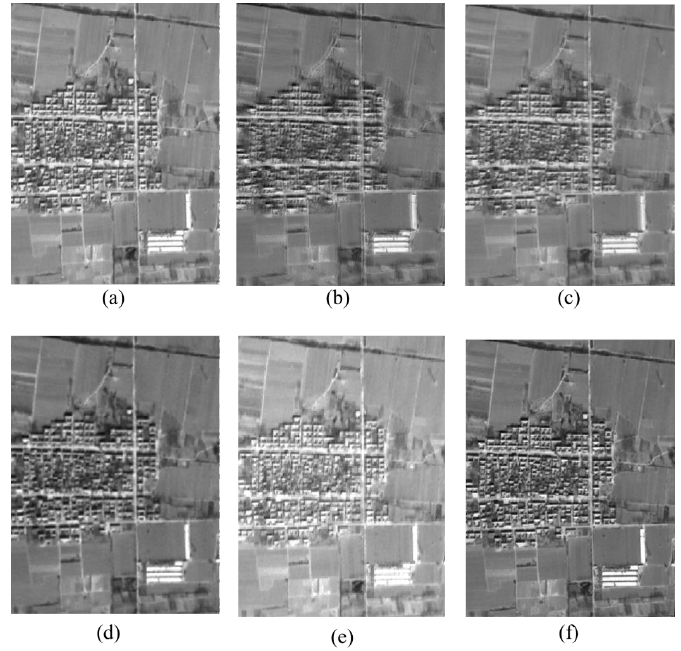
Figure 3. Comparison of the experimental ZY-3 image from nadir image, forward image, backward image, and super resolution image from forward image + nadir image, and super resolution image from backward image + nadir image, and SR image for all TLC images: ( a ) the nadir image; ( b ) the forward image; ( c )the backward image; ( d ) the super resolution image from the nadir image + forward image; ( e ) the super resolution image from the nadir image + the backward image; ( f ) the super resolution from ( d ) + ( e ).